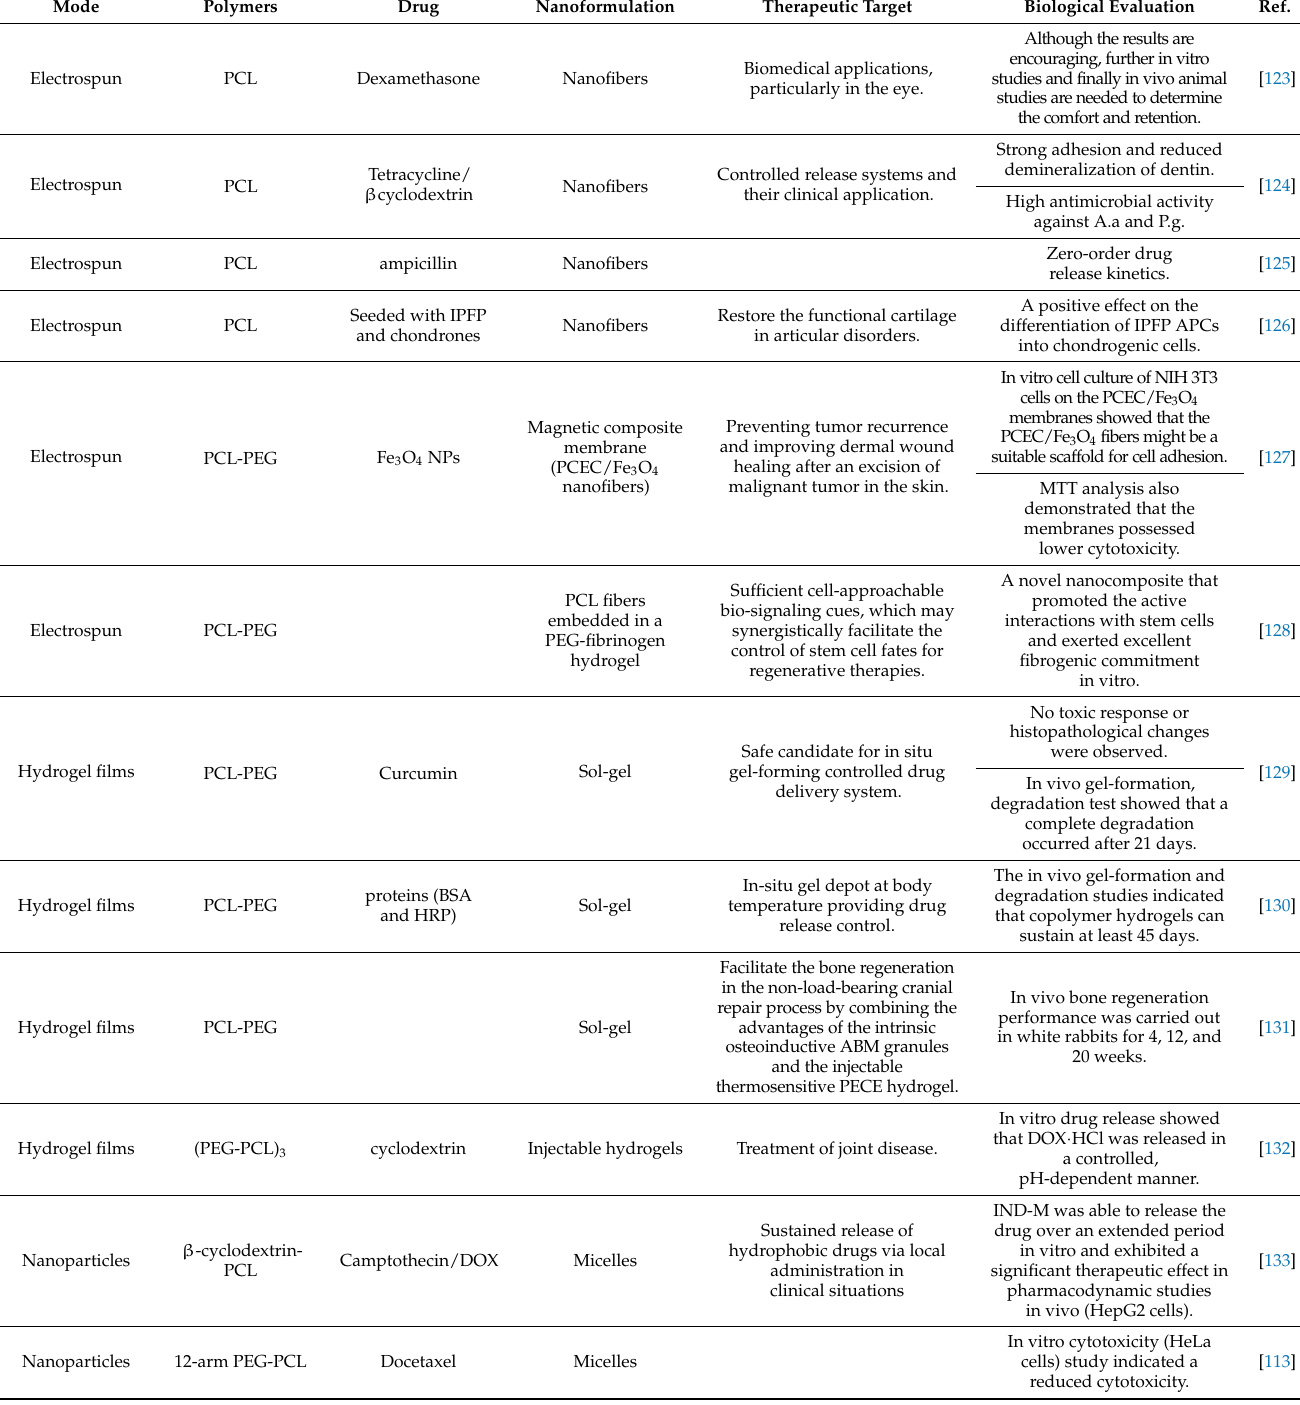
Table 1. The Biological Evaluations of PCL-based